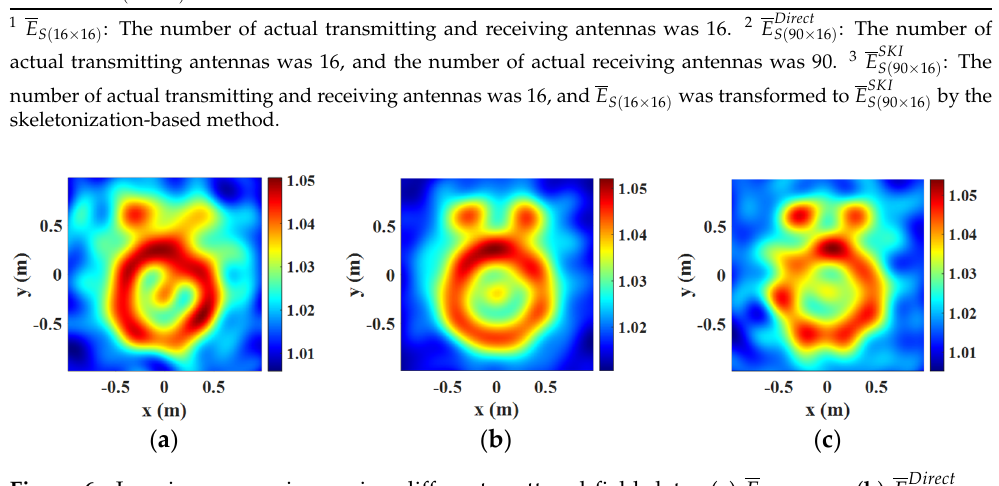
Figure 6. Imaging comparison using different scattered field data: ( a ) E S ( 16 × 16 ) ; ( b ) E SKI ( c ) E S ( 90 × 16 )